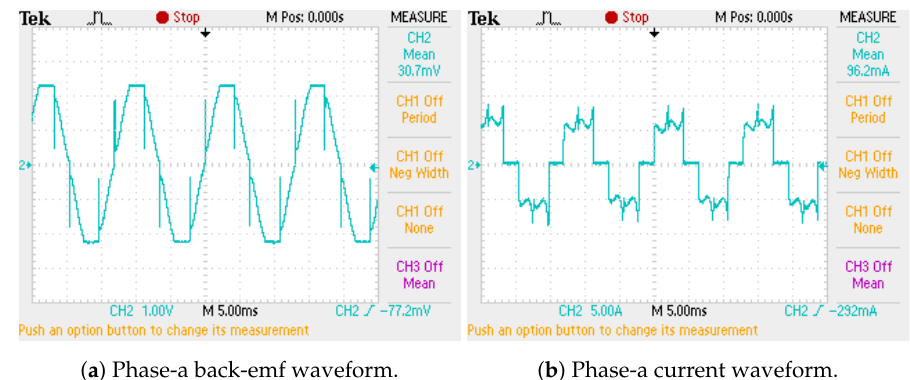
Figure 10. Experimental results for continuous